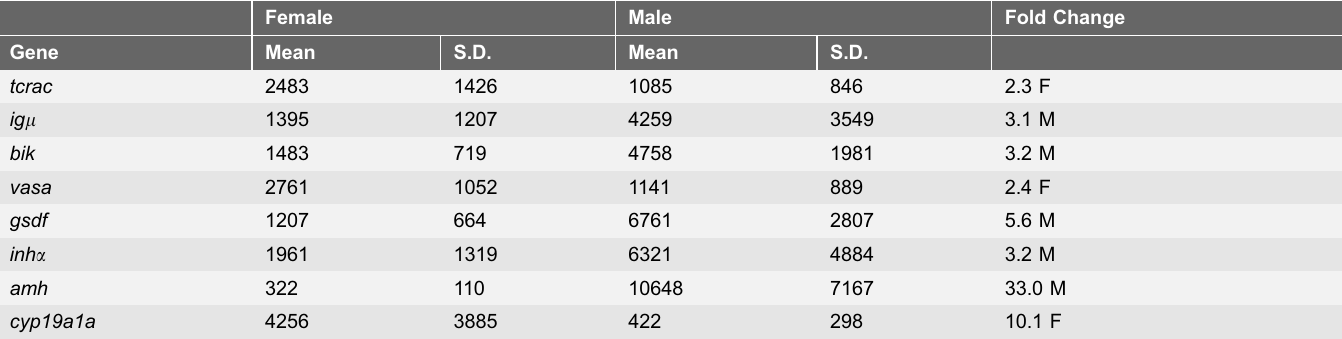
Table 1. Sex-dimorphic gene expression in juvenile zebrafish gonads.